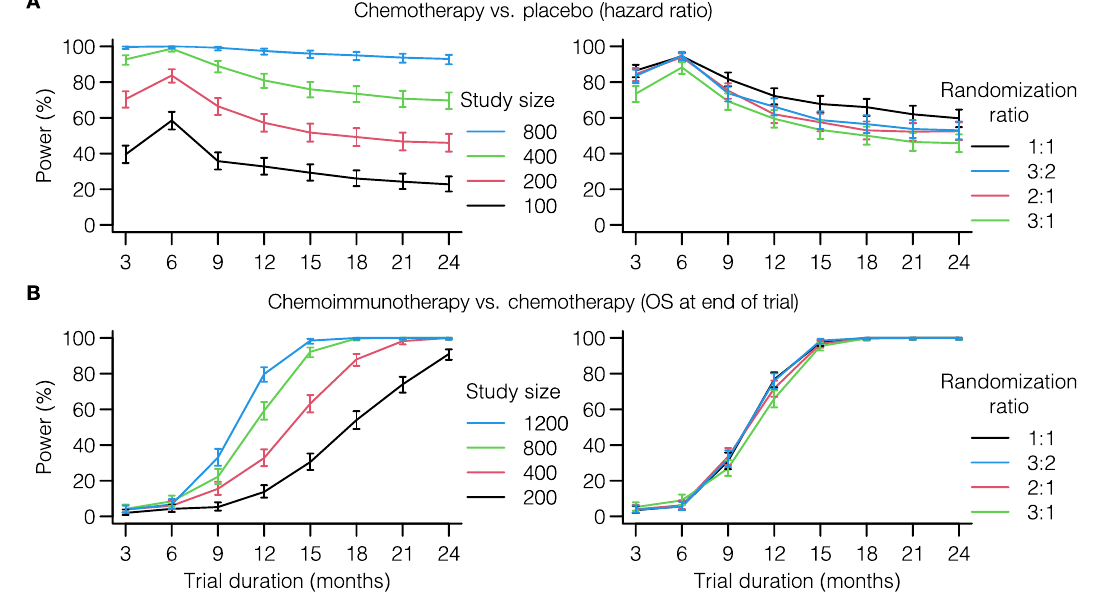
Fig. 6 | In silico trials guide decisions on OS endpoints and randomization ratiosofupcoming immunotherapy trials.A , B Insilicotrials canbeused to fi nd the optimal endpoint (panel 1) or randomization ratio (panel 2) of novel trials. A Since the survival curves in classical chemotherapy trials separate from the trial onset, the highest power – and optimal endpoint – is obtained at the end of the treatmentinterval(i.e.,aftersixmonths inthisexample;see Fig. 4A).Althoughless in fl uential, a similar observation can be made for randomization ratios (study size panel 2: 300 patients). B Delayed curve separation in immunotherapy